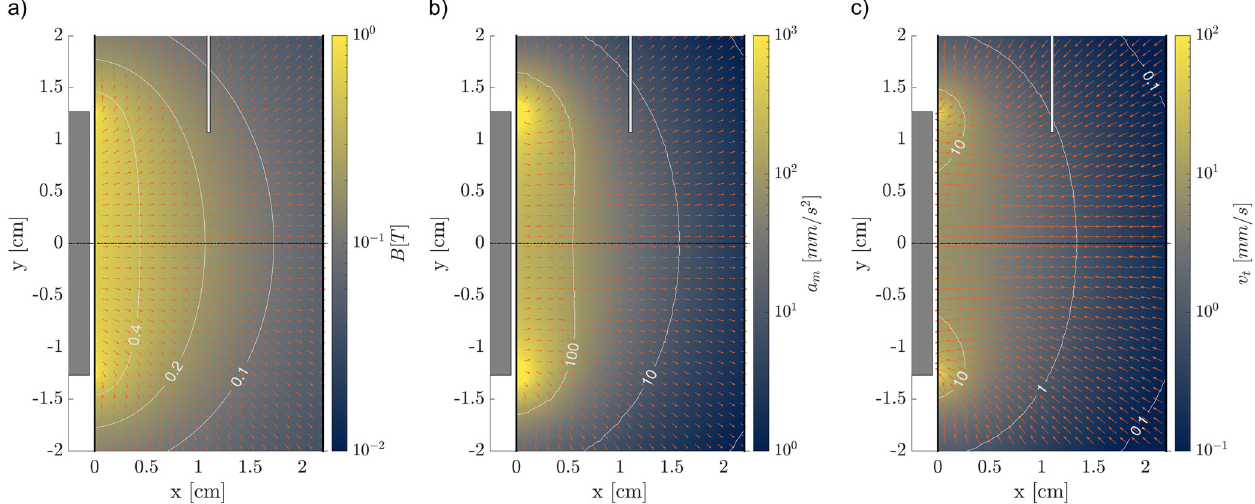
Fig. 8 Magnetic environment inside the syringe fi lled with MilliQ water. The white bar at the top and gray box at the left represent the gas injector and magnet, respectively. The panels represent the a magnetic fi eld, b diamagnetic acceleration exerted on the liquid, and c terminal velocity of a 1 mm diameter air